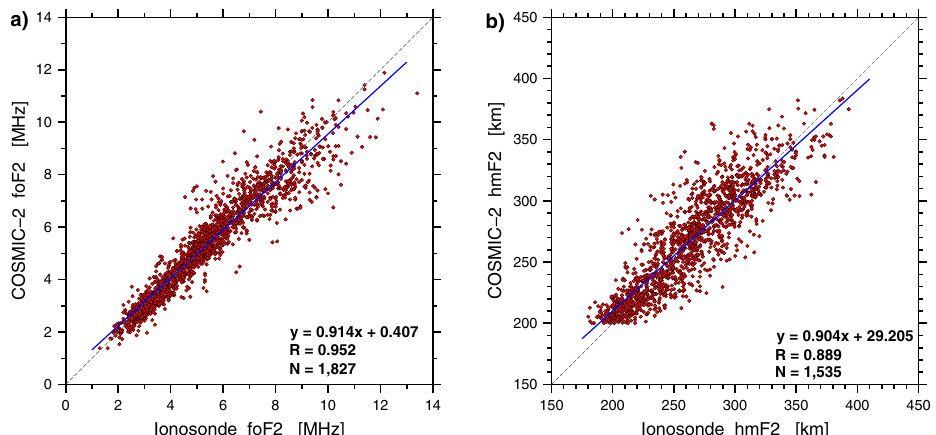
Fig. 3. Scatter plots of the COSMIC-2 RO-based foF2 and hmF2 values against the corresponding ionosonde-derived ones. The solid blue line shows the best fi t line (linear